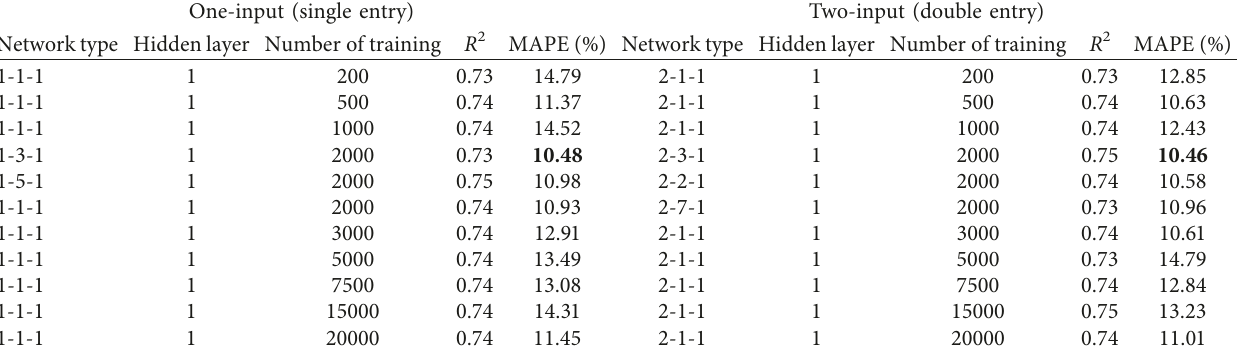
Table 2: Artificial neural network model training result. One-input (single entry) Two-input (double